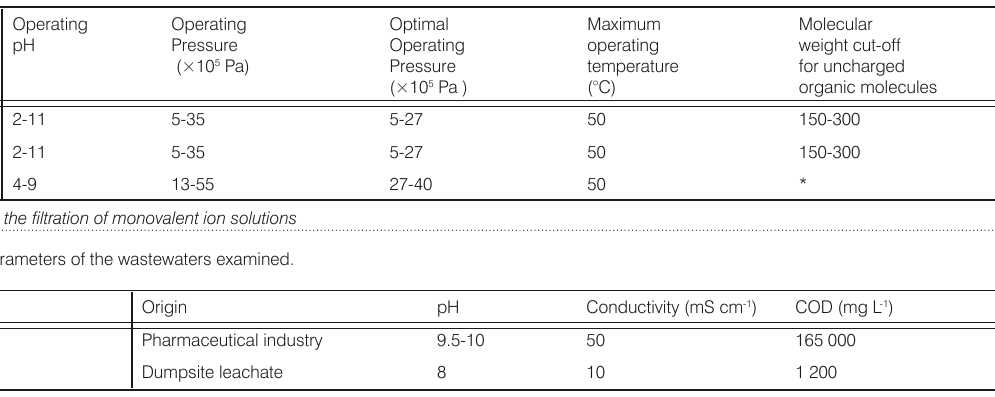
Table 1. Optimal operating conditions of the applied membranes.